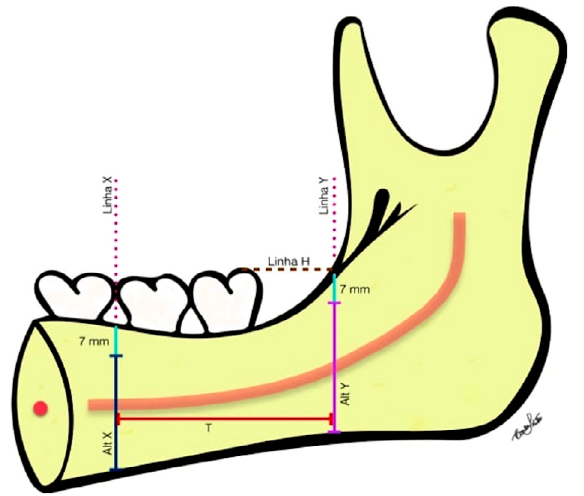
Figure 3- Illustration of the height and length of the graft block